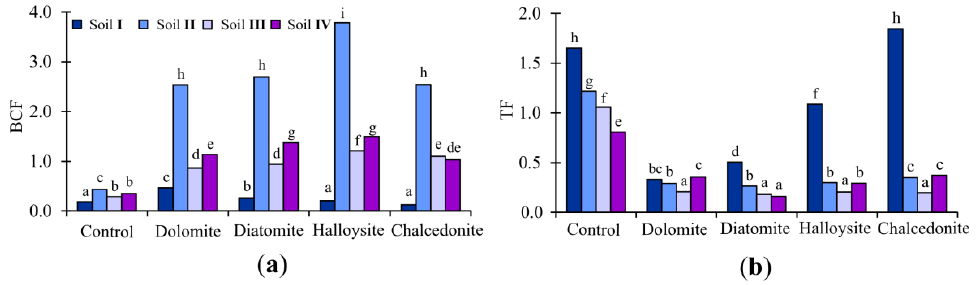
Figure 6. Effects of applying soil amendments on Cr accumulation (BCF) ( a ) and translocation (TF) ( b ) in Indian mustard.